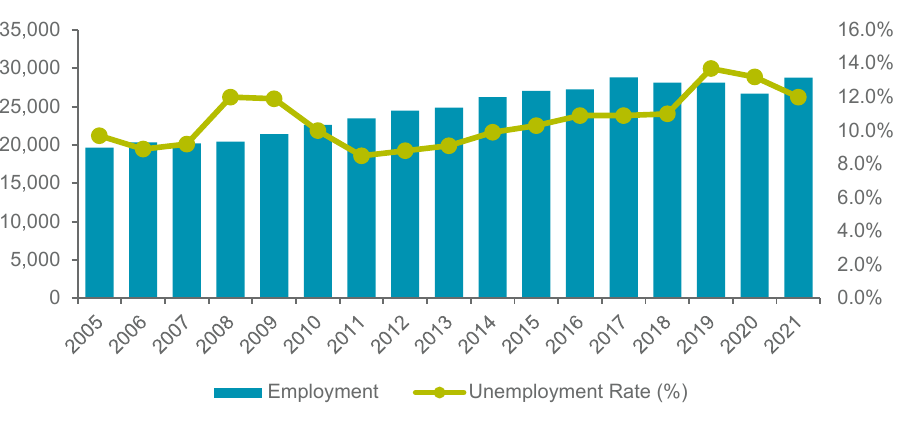
Figure 3 Employment (2005-2021) TURKSTAT, 2022